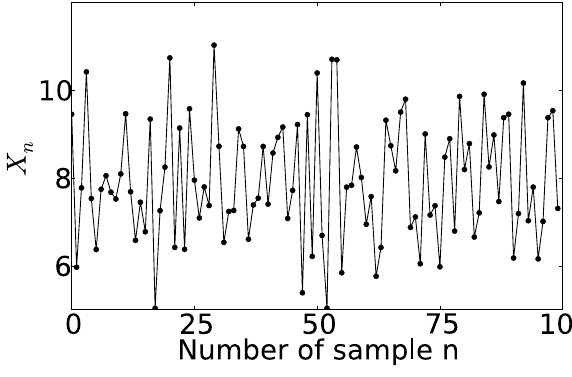
Fig. 2. A random sample of noisy signal X n = 1 . 5 G 0 . 3 n + 8 . 0 , n = 1 ,...,N,N =